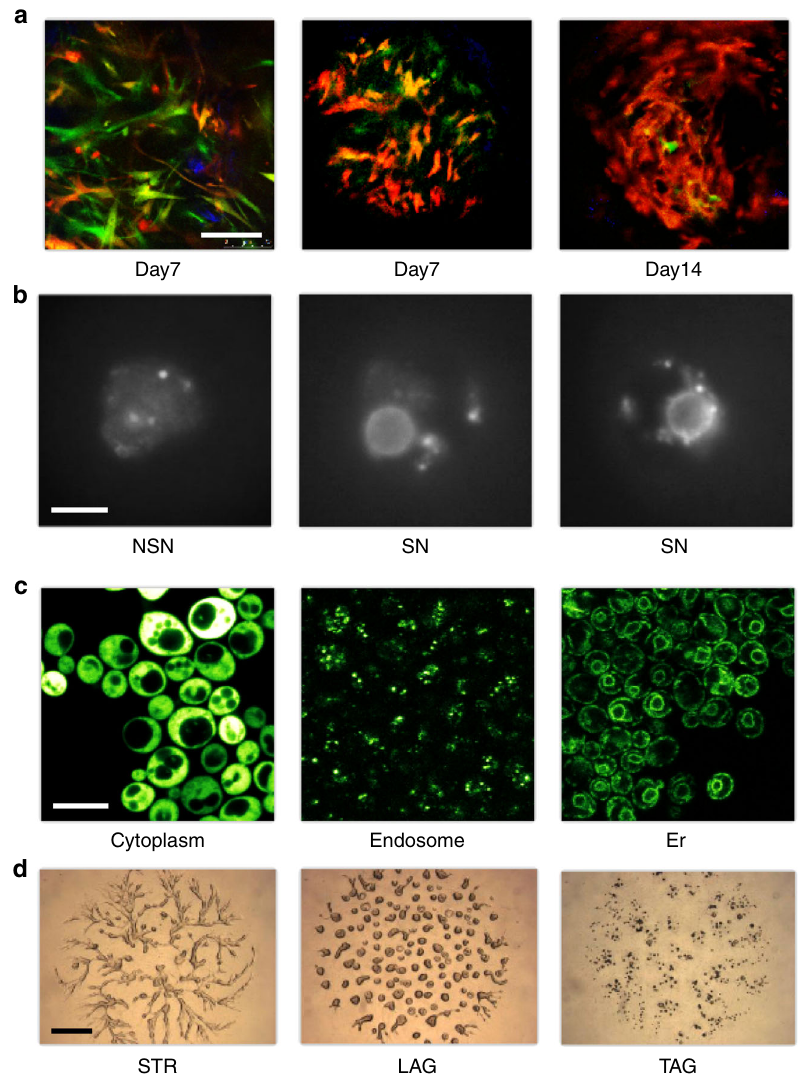
Fig. 2 Example images considered in our pilot study encompass diverse fi elds in biomedicine. a Bone-fracture repair involves skeletal stem cells. The images in this example are from mice that were the progeny of a cross between mice carrying Mx1/Tomato (red), which is a skeletal stem/progenitor cells marker, and mice carrying α SMA-GFP or Nestin-GFP (green), which are mesenchymal cell markers. The bones were injured and images were taken in vivo at 7 days and 14 days after injury, when critical events in the early repair process occur. b Chromatin organization (Hoechst staining) in the nucleus of mouse fully grown antral oocytes. Depending on their chromatin organization, oocytes are classi fi ed as surrounded nucleolus (SN), with a ring of heterochromatin surrounding the nucleolus and not surrounded nucleolus (NSN) oocytes, with a more dispersed chromatin not surrounding the nucleolus. SN oocytes are developmentally competent, whereas NSN oocytes are incompetent 18 . c Protein localization in budding yeast — fl uorescence micrographs of GFP-fusion proteins localized to the cytoplasm, endosome or endoplasmic reticulum (er) as indicated. d Images of Dictyostelium discoideum cells at different developmental stages — streaming (STR), loose aggregate (LAG), and tight aggregates (TAG). Scale bars are 100 μ m ( a ), 10 µ m ( b ), 5 µ m ( c ), or 1 mm ( d ). See Supplementary Note 1 for detailed description of the image